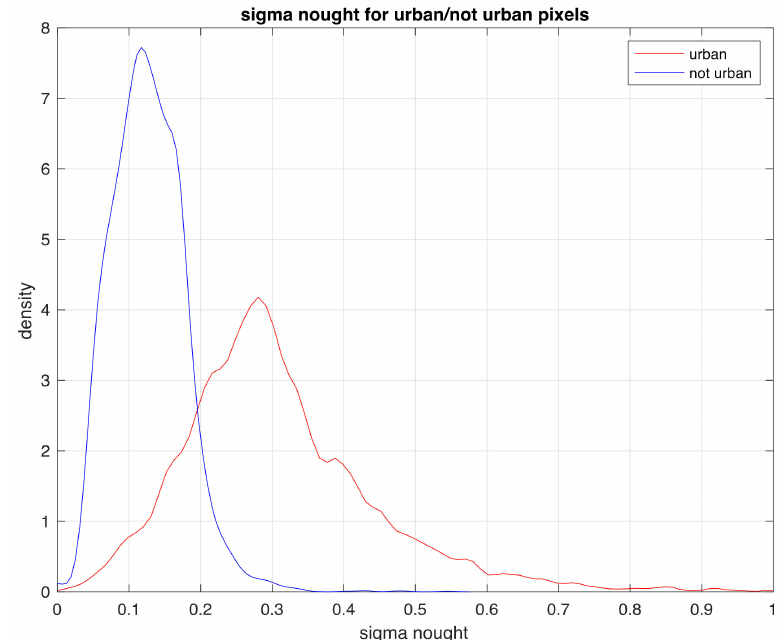
Figure 3. Sigma nought probability density estimation for Lainate,